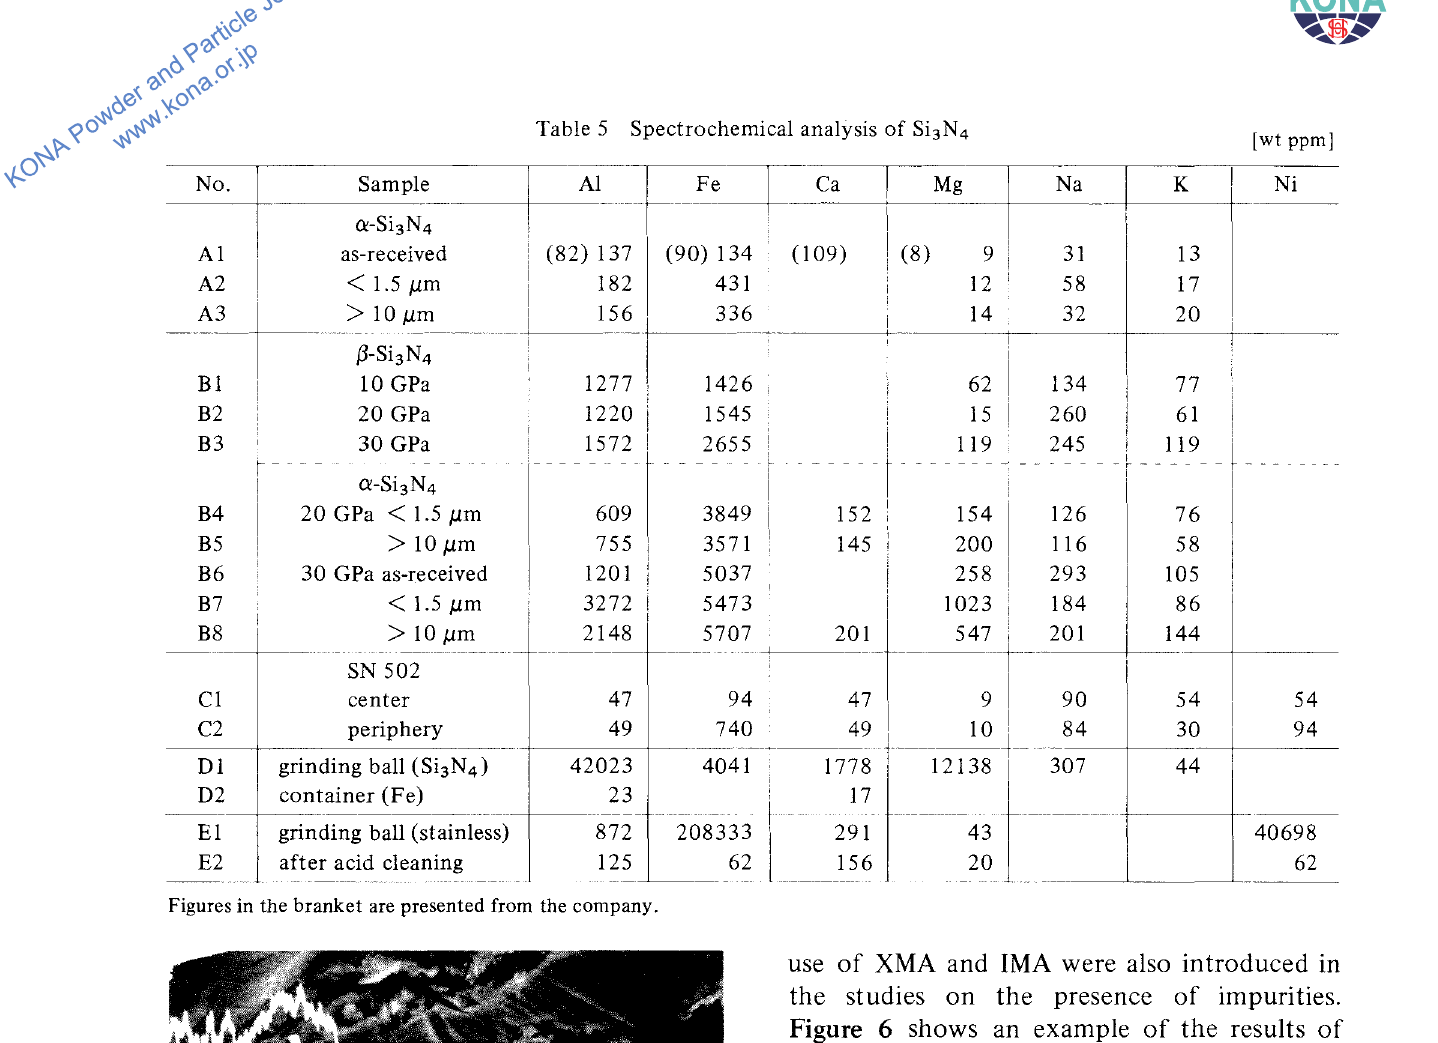
Table 5 Spectrochemical analysis of Si